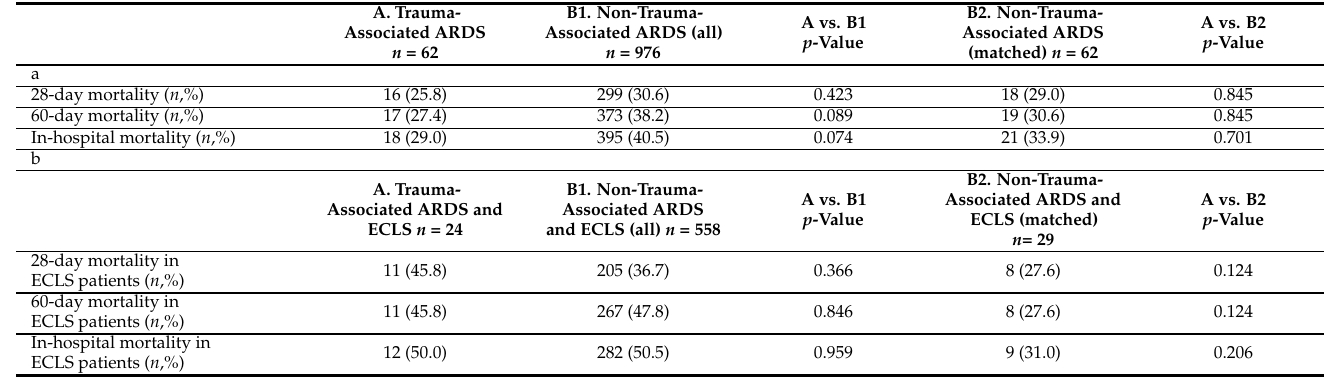
Table 2. Primary Outcome Mortality.